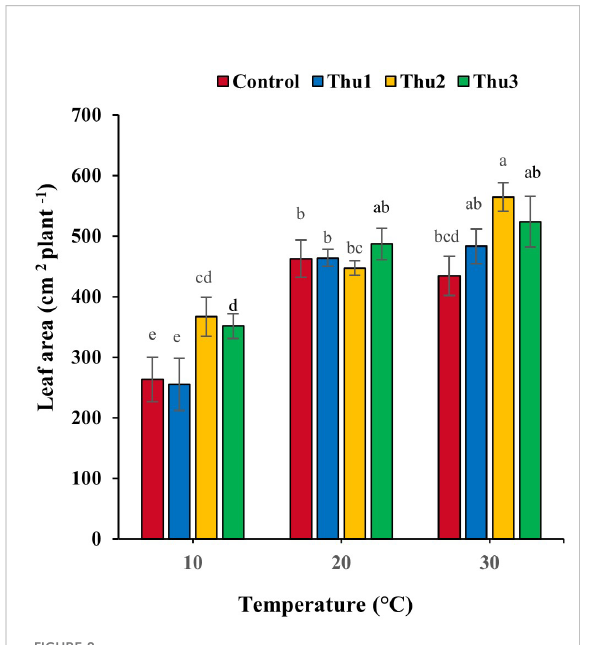
FIGURE 8 Effects of temperature and Th17 concentrations on canola leaf area. Thu1: 10 -7 M Th17, Thu2: 10 -9 M Th17, Thu3: 10 -11 M Th17. Each bar represents mean ± standard error (n=8). Means with the same letters are not signi fi cantly different ( p < 0.05).